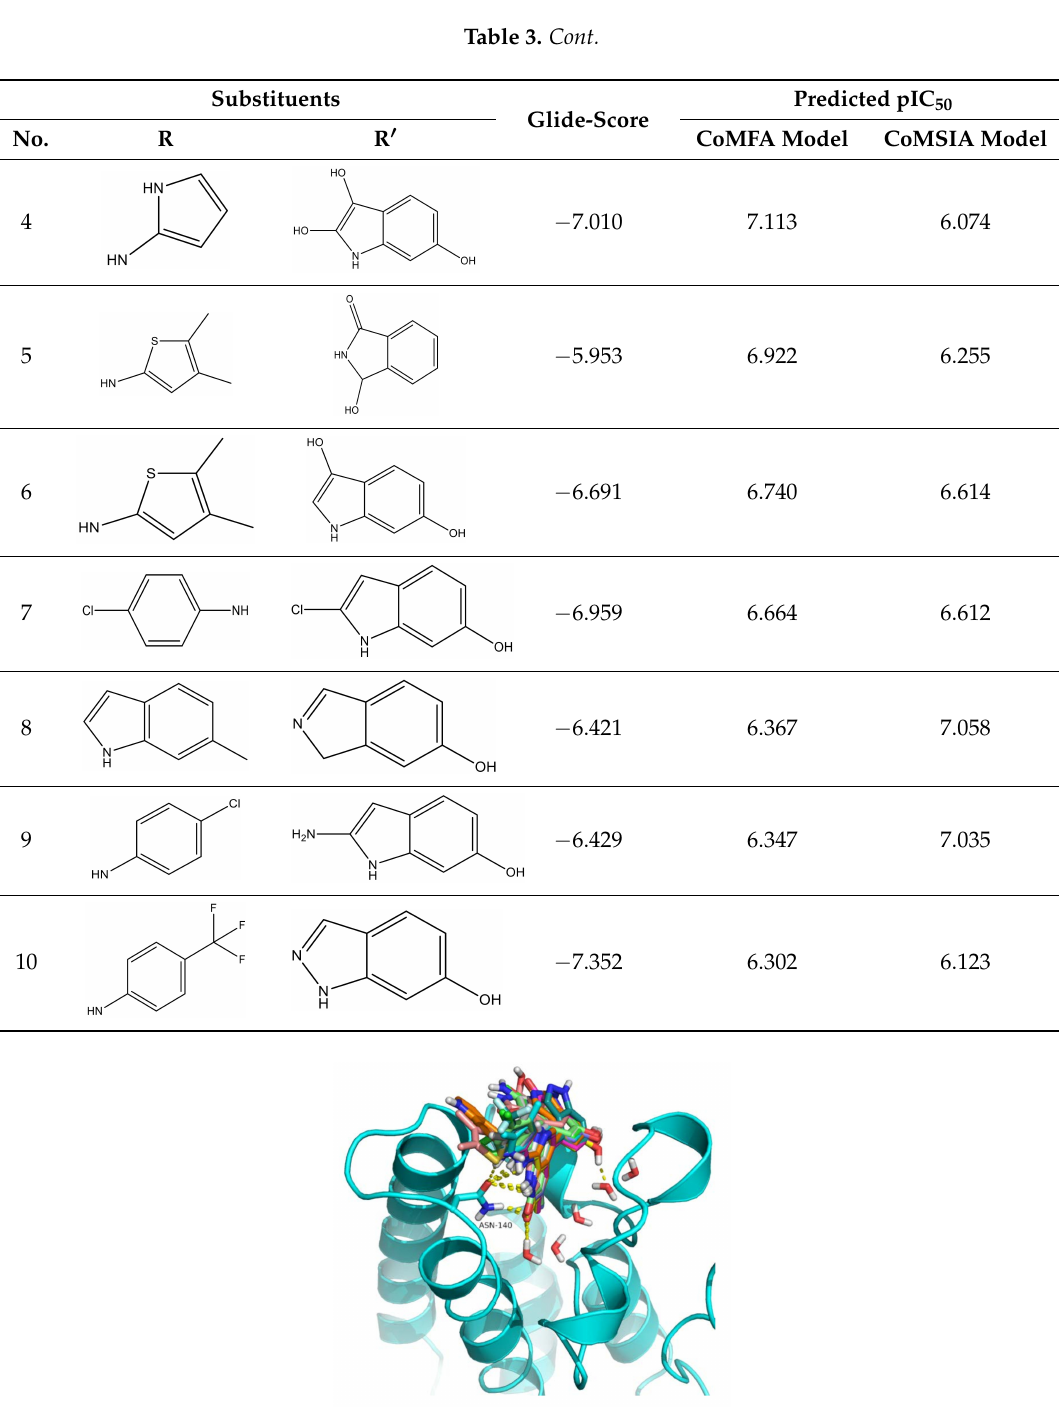
Figure 5. Docking pose of the newly designed compounds in the active site of the BRD4 protein (cyan) along with water molecules (red and white sticks). The yellow dotted lines represent hydrogen